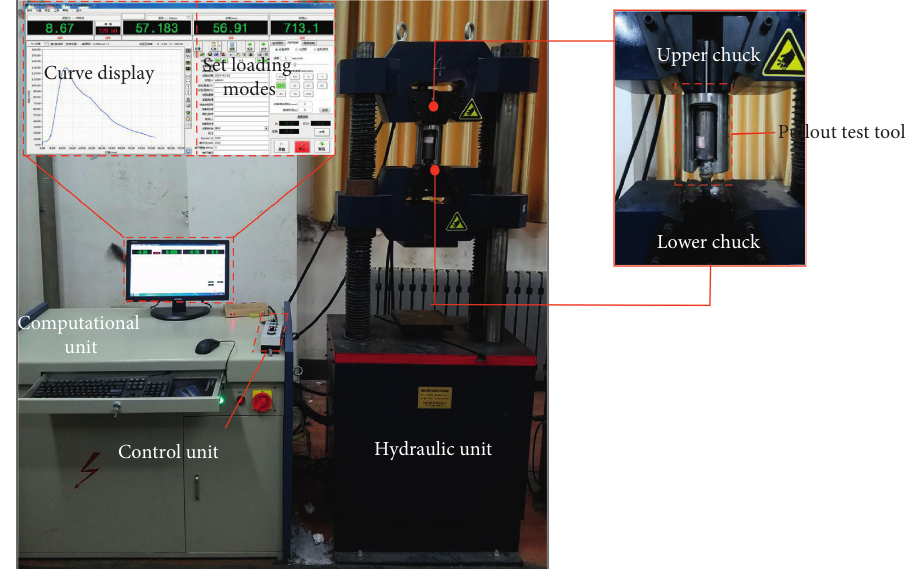
Figure 15: Photographs of the pullout test equipment, showing details of the computational unit with a data display and set loading modes (upper left) and the upper and lower chucks flanking the pullout test tool (upper